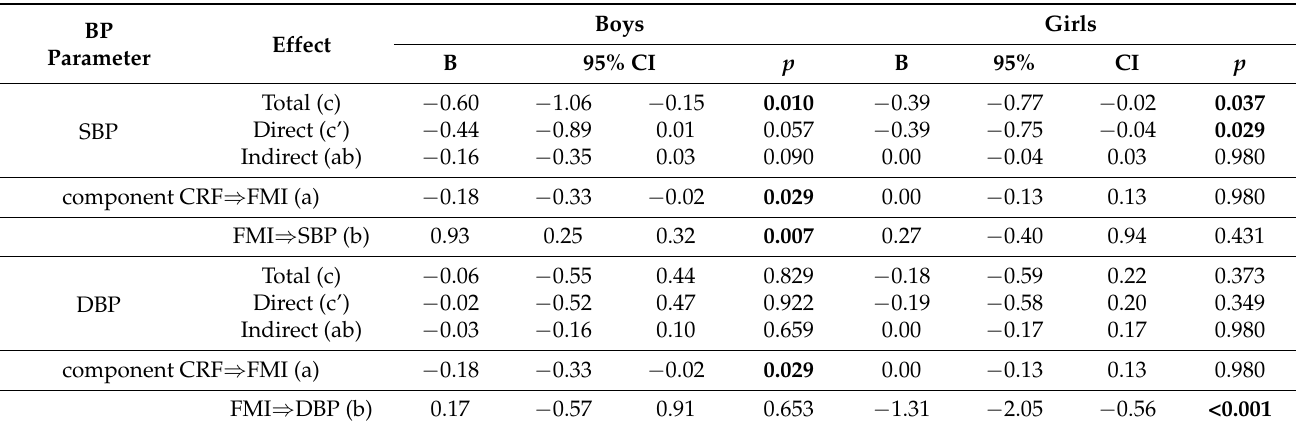
Table 4. The mediation effects of the baseline FMI: total (path c), direct (path c’), and indirect (ab) with its components (paths a and b).